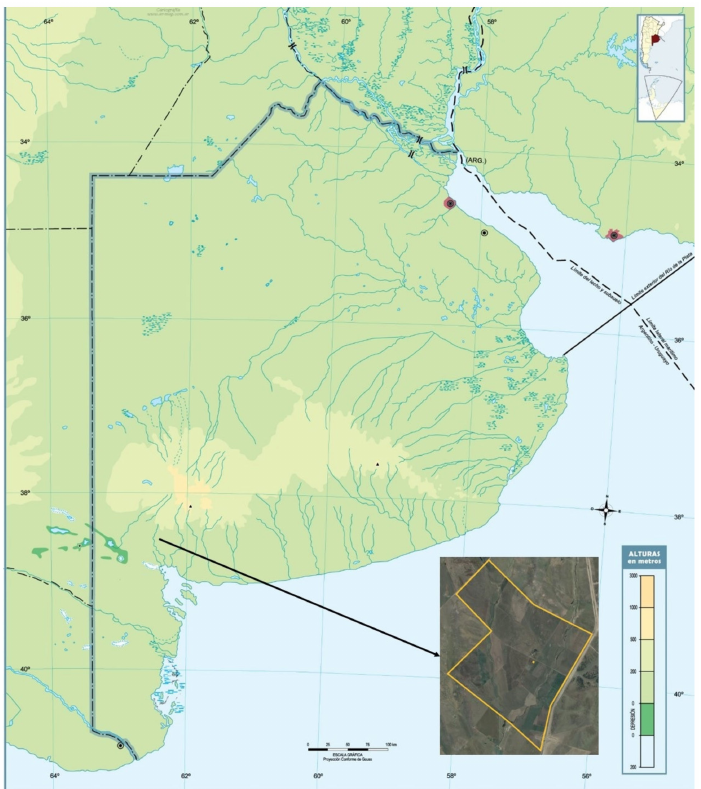
Figure 1. Location of the experimental site in Bah í a Blanca, Buenos Aires Province,